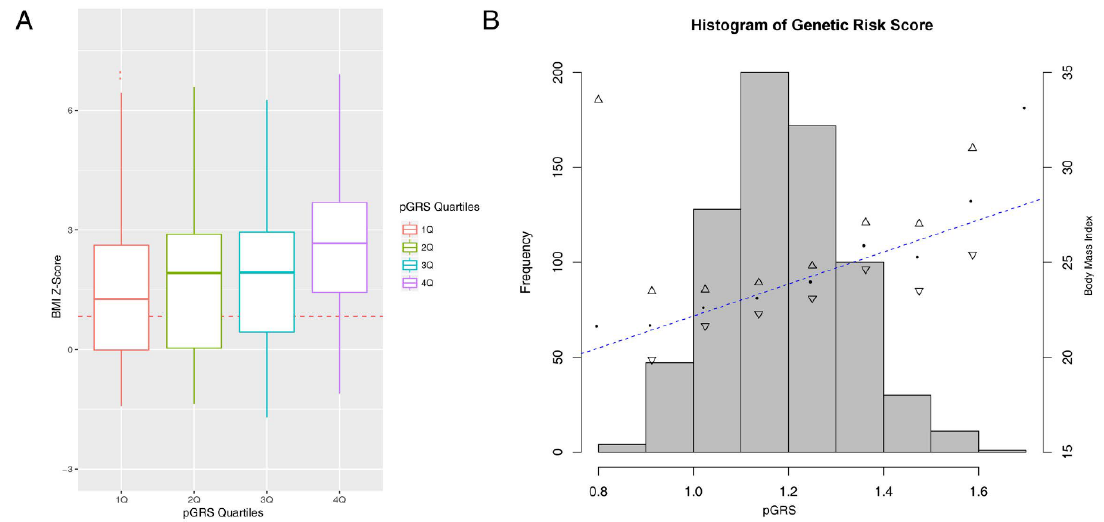
Figure 2. Association between polygenetic risk scores (pGRS) and body mass index (BMI) Z-score in the study population 1; analysis adjusted for origin and pubertal status of children. ( A ) Boxplot graph for BMI Z-Score according to each quartile of the pGRS; the dashed line in the plot represents the cut-o ff BMI Z-Score for overweight and obesity in the study population 1. ( B ) Histogram of genetic risk score values in the study population 1 and their correlation with BMI (R 2 =